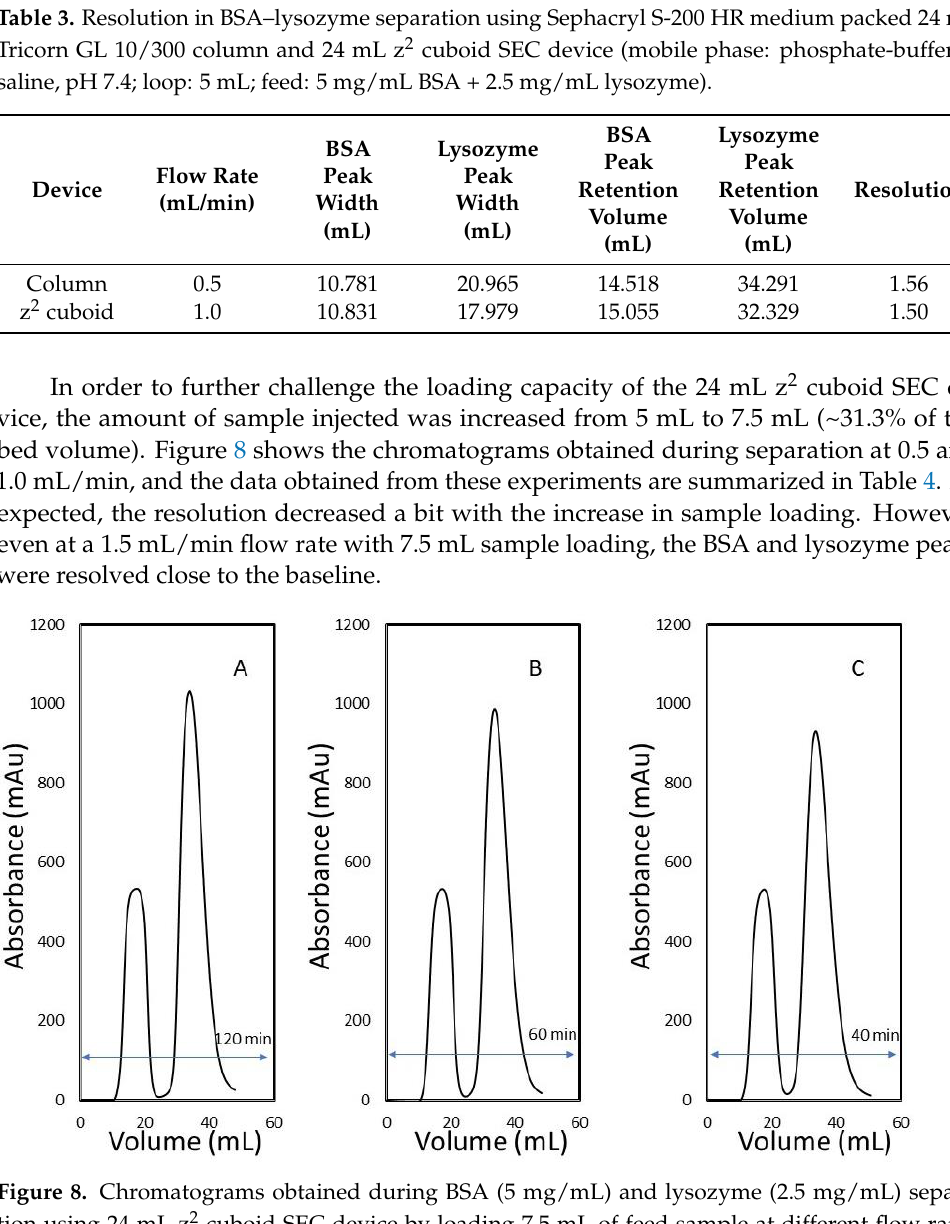
Figure 7. Chromatograms obtained during BSA (5 mg/mL) and lysozyme (2.5 mg/mL) separation using ( A ) the 24 mL Tricorn GL 10/300 column at a 0.5 mL/min flow rate and ( B ) the 24 mL z 2 cuboid SEC device at a 1 mL/min flow rate (medium: Sephacryl S-200 HR; mobile phase: phosphate-buff- ered saline (pH 7.4); loop size: 5 mL).